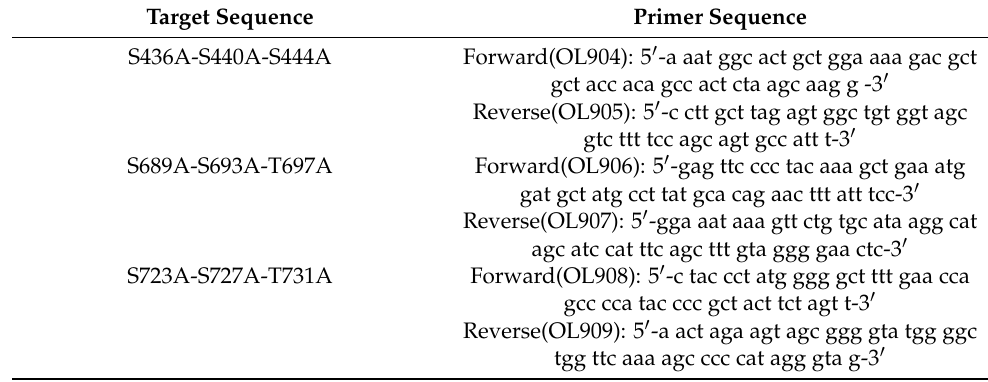
Table 1. M1, M2, and M3 using the pGFP2-N2-AHR plasmid as the template for QuikChange mutagenesis. Target